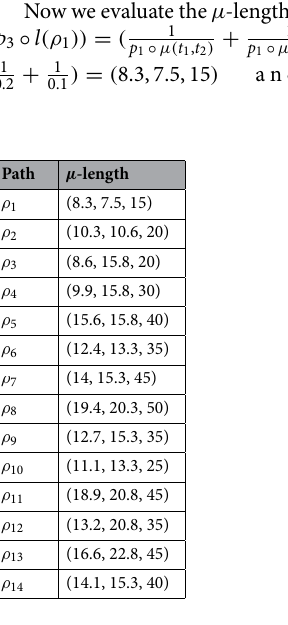
Table 3. µ -lengths of the paths between t 1 and t 3